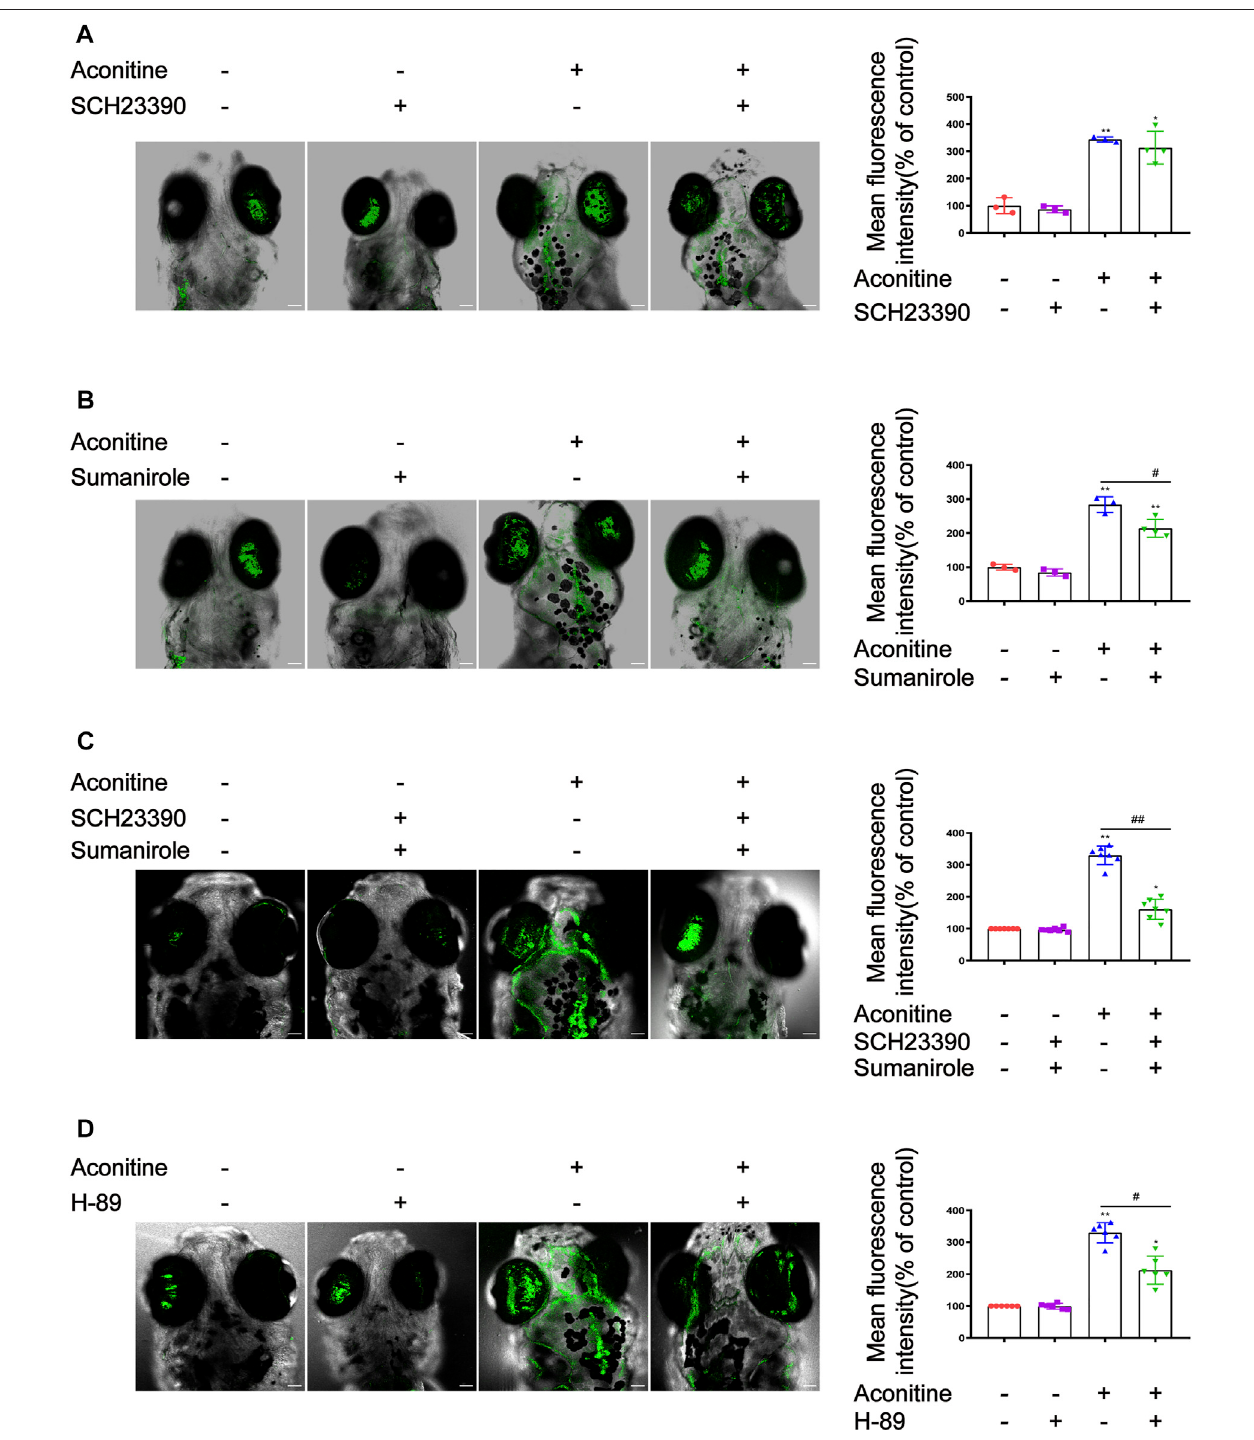
FIGURE 7 | Effects of SCH23390, sumanirole and H-89 on intracellular Ca 2+ changes induced by aconitine in zebra fi sh larvaes. (A) Effects of SCH23390 on intracellular Ca 2+ changes induced by aconitine. (B) Sumanirole suppressed aconitine-induced the increase of intracellular Ca 2+ . (C) Pretreatment with SCH23390 and sumanirole inhibited the rise of intracellular Ca 2+ aconitine-stimulated. (D) H-89 inhibited the increase of intracellular Ca 2+ induced by aconitine. All photographs were taken under a confocal microscope (100×). The values are expressed as mean ± SD, n = 8. * p < 0.05, ** p < 0.01, *** p < 0.001 vs. control groups. # p < 0.05, ## p < 0.01, ### p < 0.001 vs. aconitine-treated groups.